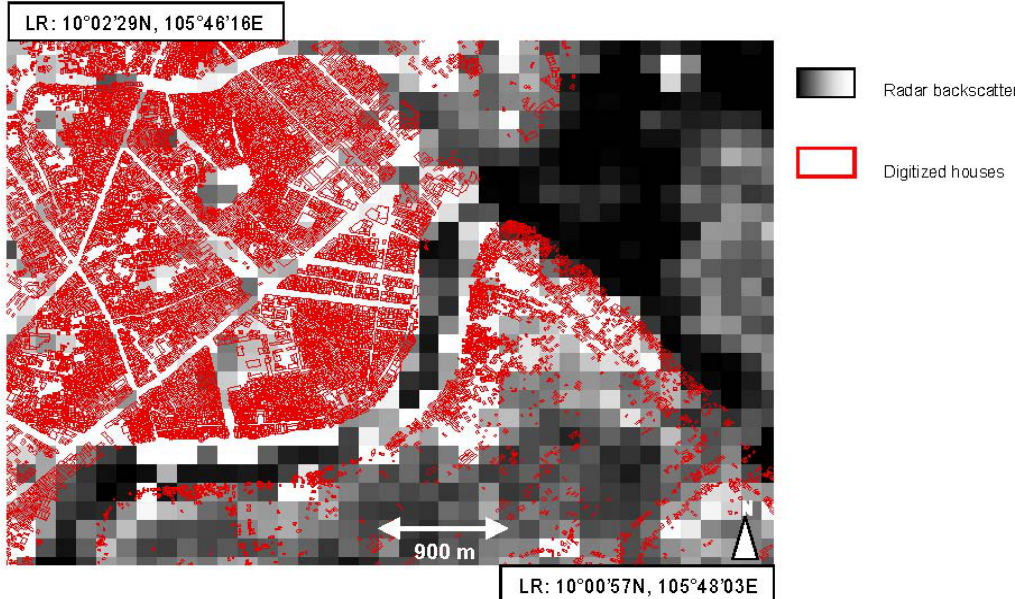
Figure 8. Challenges for automatic water extraction from 150 m resolution Envisat ASAR GM data. The river is partially strongly “over-radiated” by houses acting as corner reflectors or hemispherical